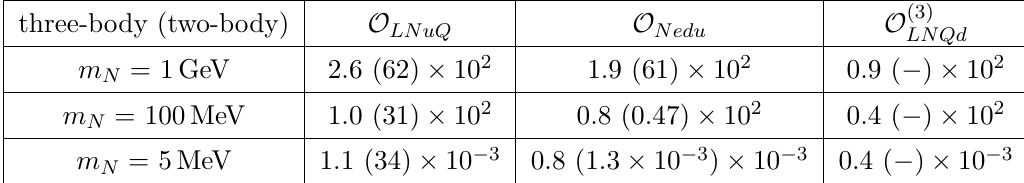
Table 5 . The maximum number of signal events for either of the decay operators, O Ne and O LNLe , expected at Belle II with 50 ab − 1 .